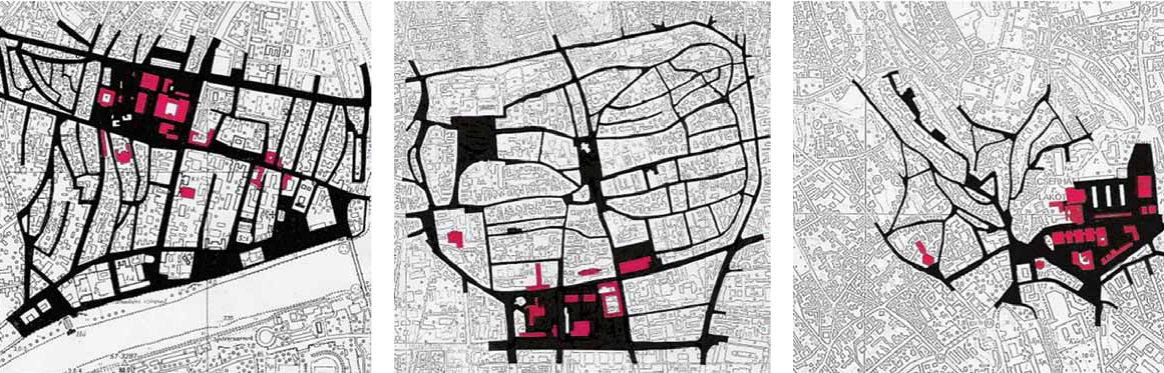
figs 17–19. Three big Hungarian historical town, that represent new urban fabric, structure and street network organised by new institutial centres without historical context – Szolnok, Pécs, Veszprém ( New public buildings of state socialism with red colour